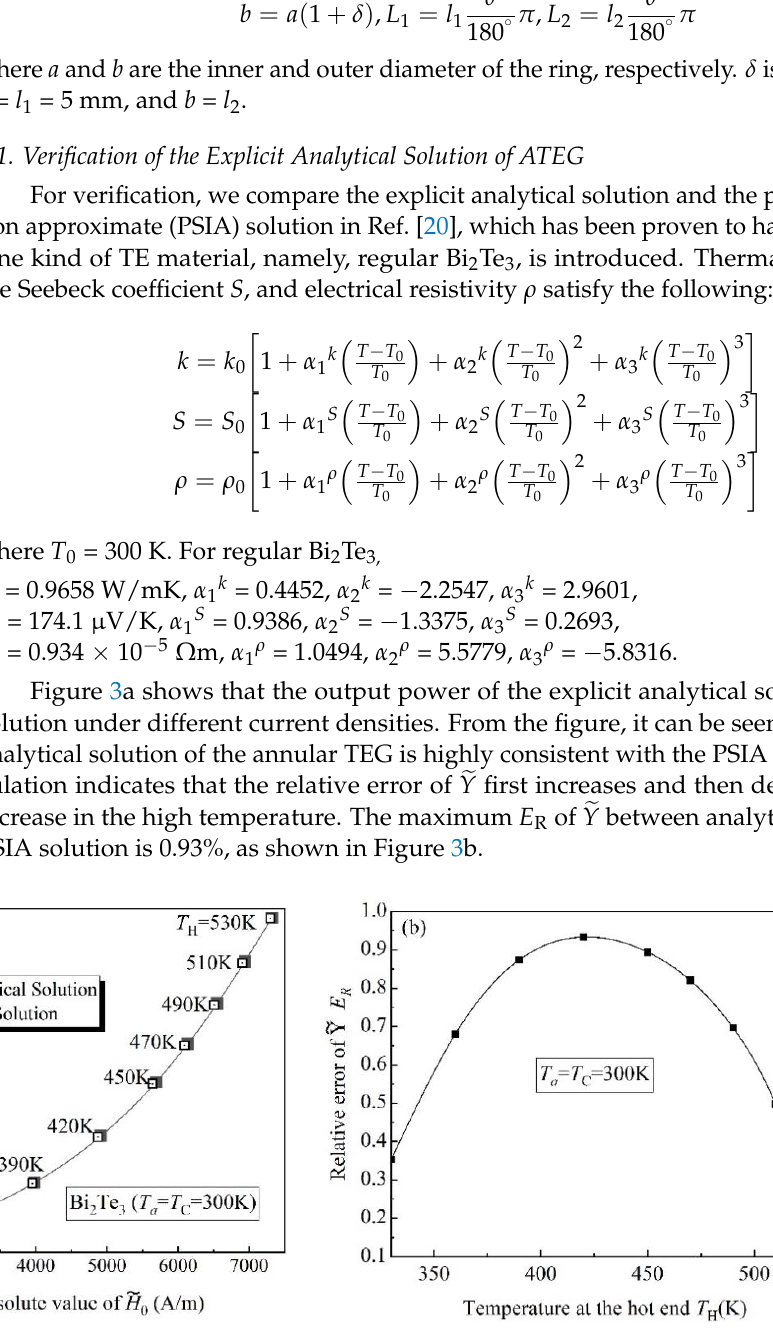
Figure 3. Comparison between explicit analytical and PSIA solution, ( a ) (cid:101) Y versus (cid:101) H 0 ; ( b ) E R of (cid:101) Y at different hot temperatures.